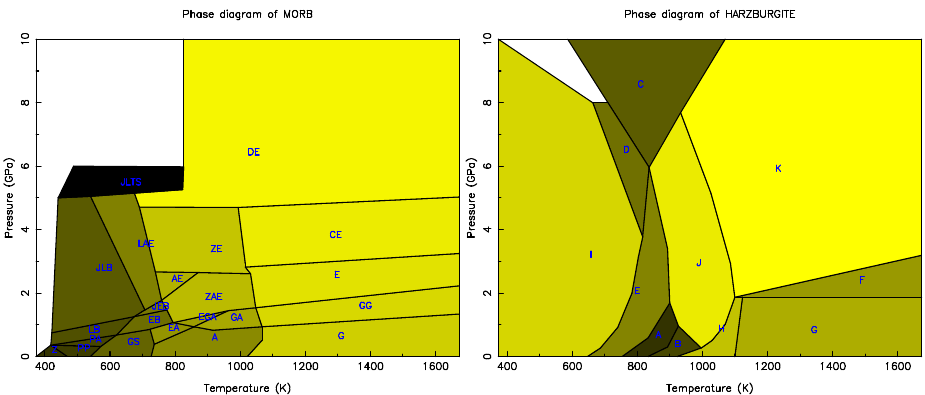
Fig. 3: Phase diagrams for a typical MORB composition (left) and a harzburgite composition (right) according to Hacker (2003). Phase regions have been extrapolated to higher pressures and temperatures. Abbreviations (left): Z: zeolite; PP: prehnite